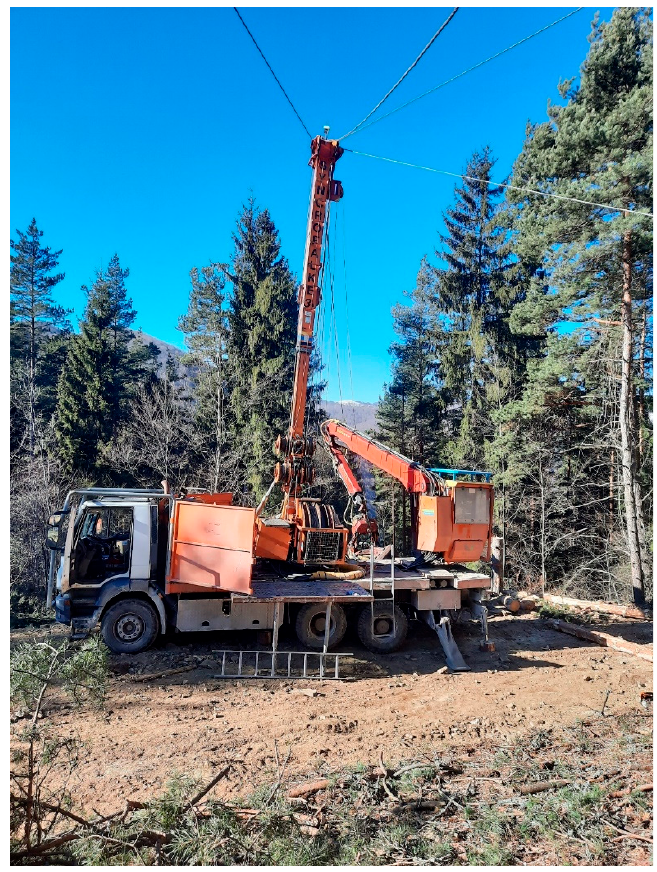
Figure 2. Syncrofalke 3t Processor Tower Yarder.